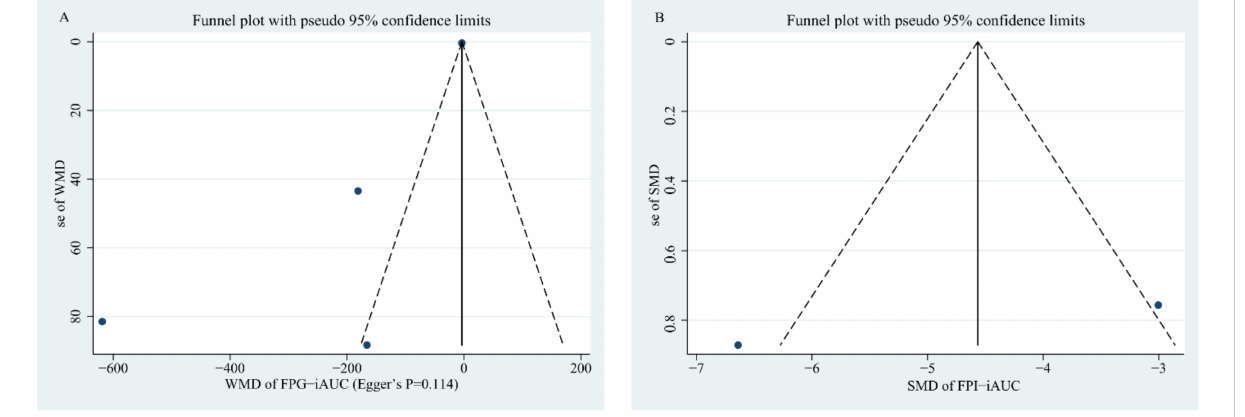
Figure 4. Funnel plot measuring the publication bias for the effects of whole grain consumption on G-iAUC ( A ) and I-iAUC ( B ) in diabetic